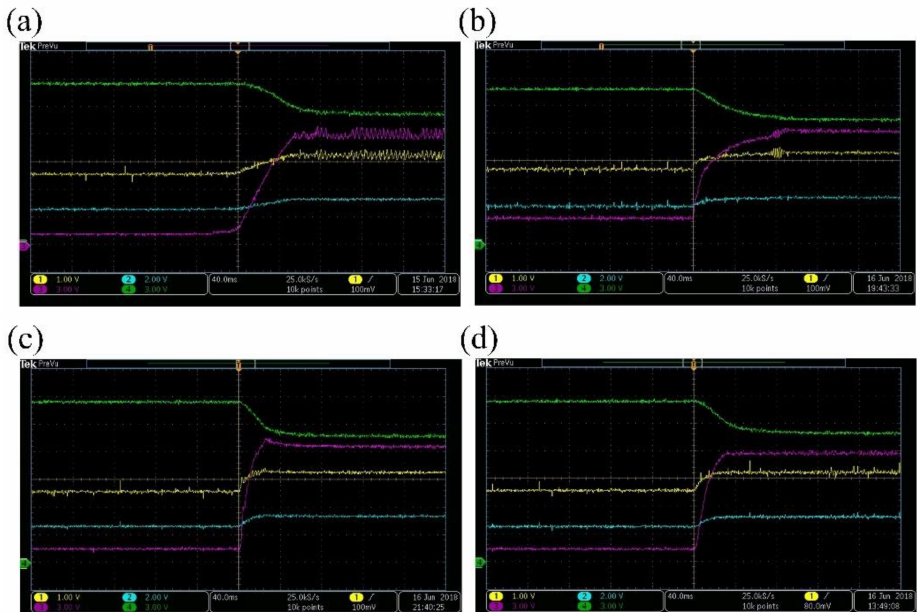
Figure 10. Transient response: ( a ) current control by SMC; ( b ) current control by adaptive backstep- ping SMC; ( c ) current control by RBFNN; ( d ) voltage control by